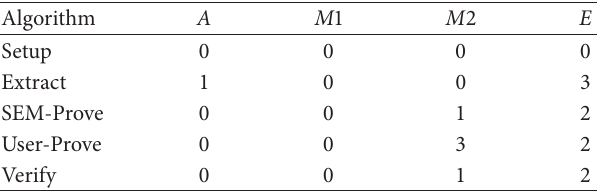
Table 3: Operation costs for the BNN-SM-IBI scheme. Algorithm